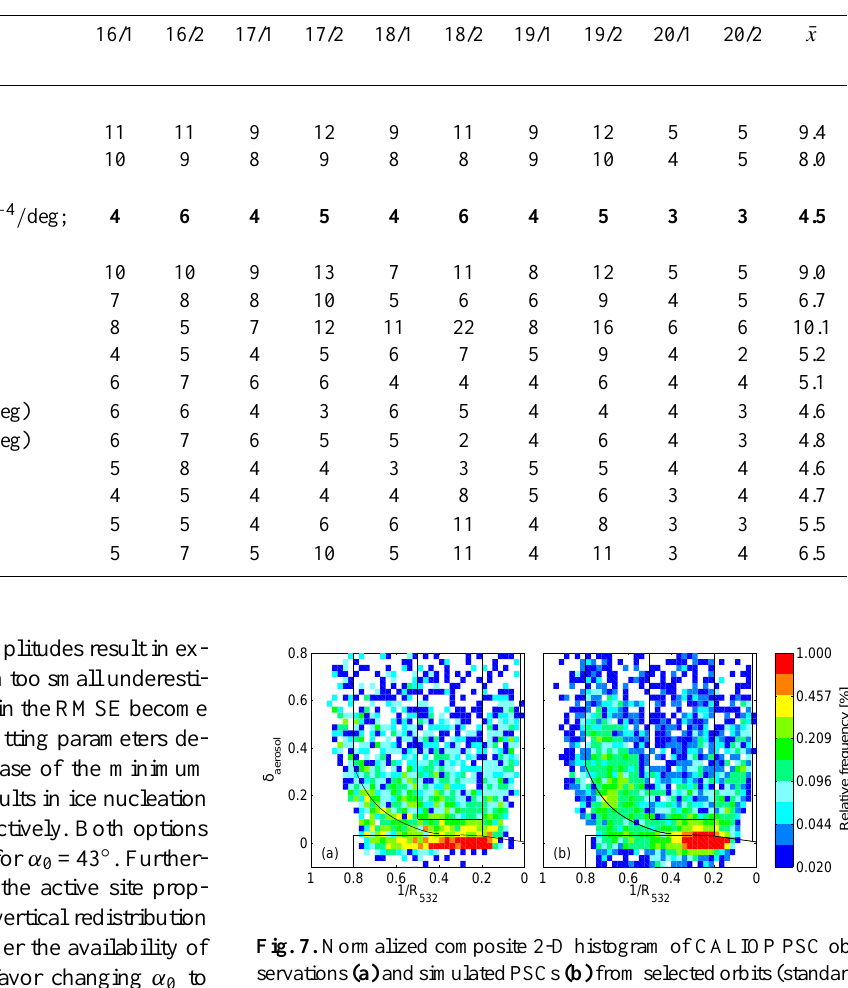
Table 1. Root-mean-square errors (RMSE) of selected ZOMM simulations in comparison to CALIPSO observations (Eq. 8, rounded to next integer). See text for a more detailed description. Calculations are performed with a horizontal resolution of 100km. In each specific case, only one parameter is changed with respect to the so-called standard case (bold) with the following set of parameters: fluctuations: with; ice on foreign nuclei prefactor: P pre =5 × 10 − 4 deg − 1 ; ice on foreign nuclei minimum contact angle: α 0 =43 ◦ ; ice on NAT contact angle: α =60 ◦ ; NAT on ice parameter: γ =164K 3 . The mean ¯ x is shown for the parameterization of each specific case averaged over all orbits.